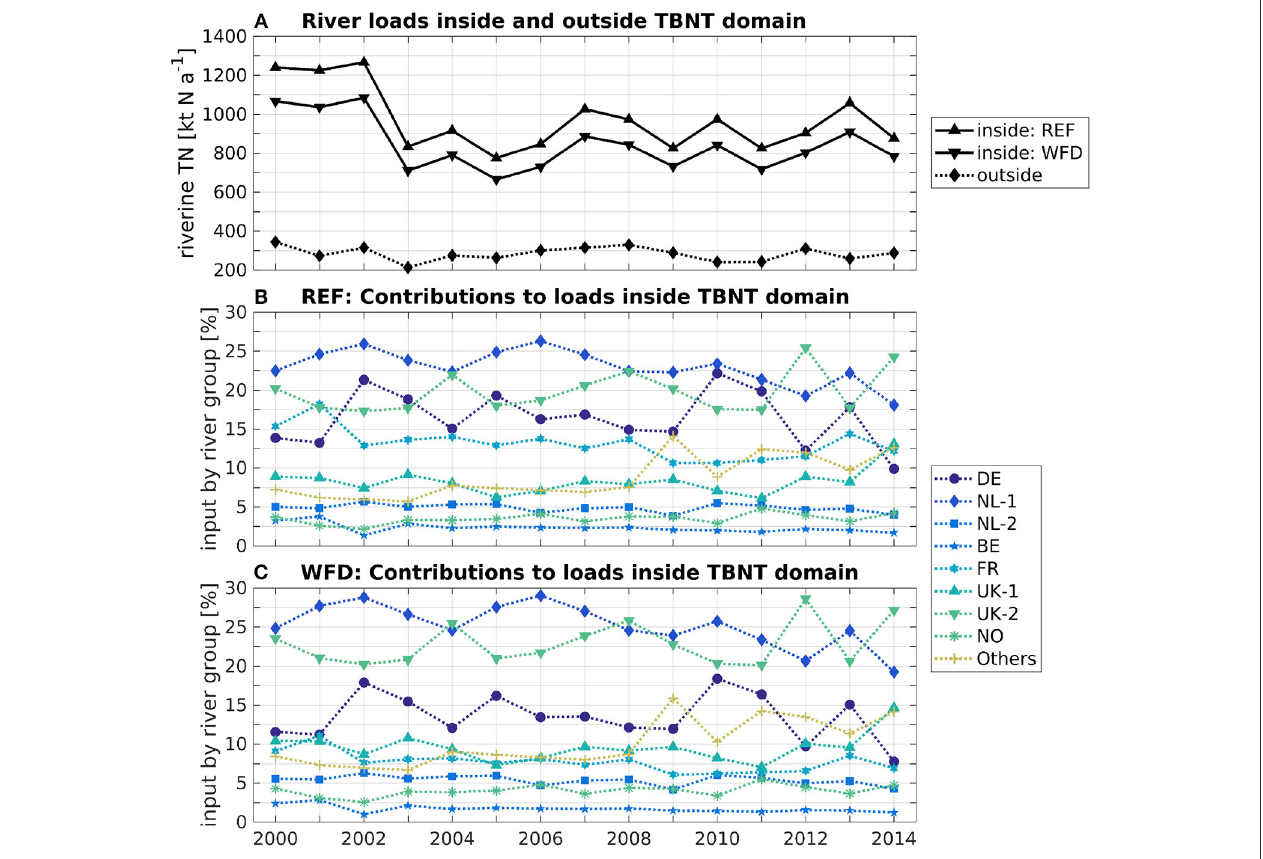
FIGURE 2 | Time series of (A) overall riverine TN input into the model domain inside (solid lines; for reference (“REF”) and WFD scenario) and outside the TBNT domain (dotted line), and the relative contributions from the different sources to the loads inside the TBNT domain for (B) the reference simulation and (C) the WFD reduction